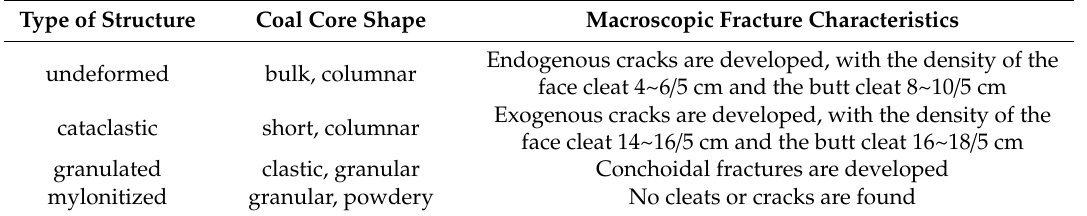
Figure 2. Macroscopic characteristics of samples from Well L1. ( a ) Undeformed coal, No. 11 coal seam, 417.45–417.97 m in depth. ( b ) Cataclastic coal, No. 5 coal seam, 372.84–373.34 m in depth. ( c ) Granulated coal, No. 11 coal seam, 414.45–414.97 m in depth. ( d ) Mylonitized coal, No. 11 coal seam, 413.96–414.45 m in depth. Table 1. Tectonically deformed coal (TDC) and its corresponding shape and macroscopic fracture characteristics in the coal core samples of the study area.